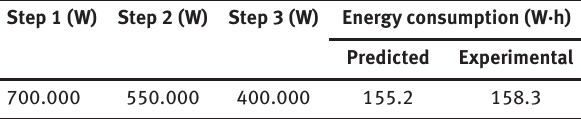
Table 7: Energy consumption statistics under the optimized conditions.